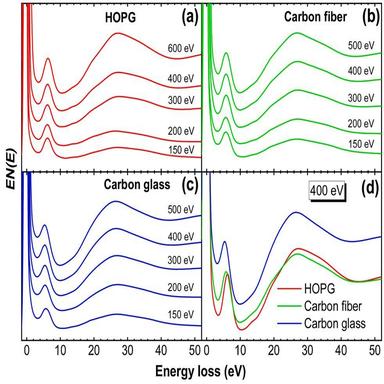
REELS spectra at different primary energies for (a) HOPG, (b) carbon fiber and (c) carbon glass. (d) Comparison on the RELLS spectra for the three materials. The energy spectrum is normalized by the elastic peak height.